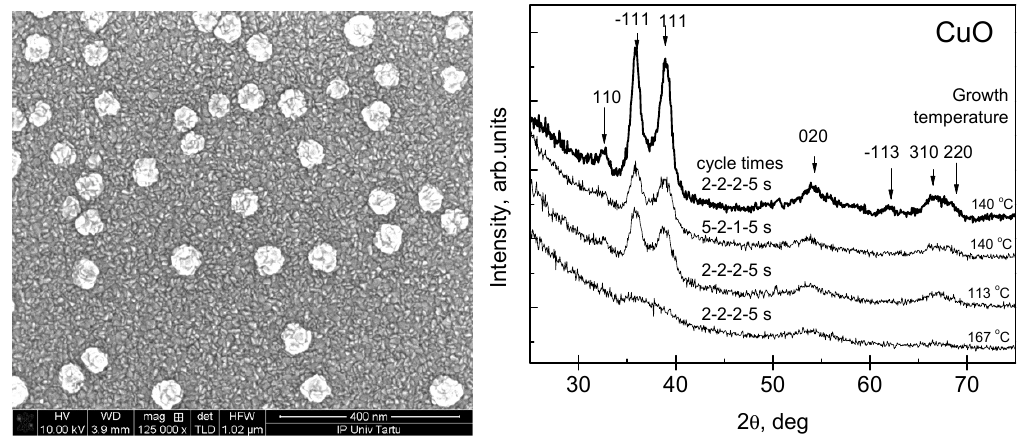
Figure 2. Representative SEM image ( left panel , cycle times 2-2-2-5 s at 140 °C) and grazing incidence X-ray diffractometry (GIXRD) patterns ( right panel ) for the cupric (CuO) films grown on Si substrate by using 500 ALD cycles.